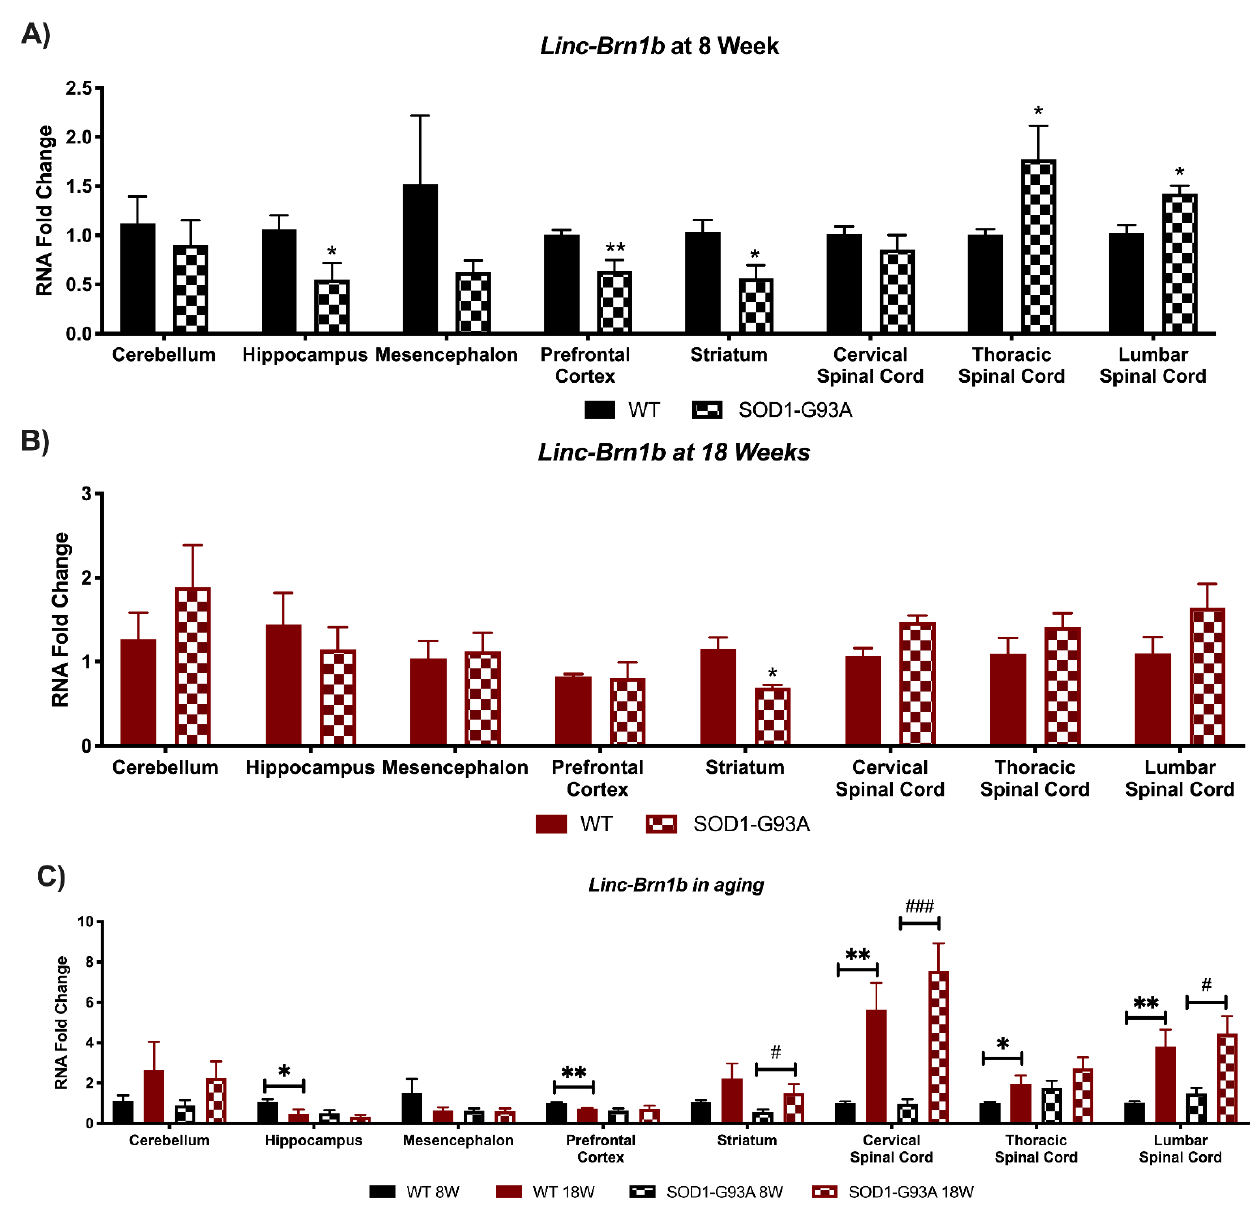
Figure 2. Global perturbations found in the expression of Linc-Brn1b in CNS areas of SOD1-G93A mice. RNA expression levels were evaluated by Real Time-PCR in the different conditions. Data are expressed as mean ± SEM. ( A ) Linc-Brn1b expression in 8 weeks old WT ( n = 6) mice versus 8 weeks old SOD1-G93A mice ( n = 6). * p < 0.05, ** p < 0.01 vs. WT. ( B ) Linc-Brn1b expression in 18 weeks old WT ( n = 6) mice versus 18 weeks old SOD1-G93A mice ( n = 6). * p < 0.05 vs. WT. ( C ) Linc-Brn1b expression in 8 weeks old WT mice versus 18 weeks old WT ( n = 6) and 8 weeks old SOD1-G93A mice versus 18 weeks old SOD1-G93A mice ( n = 6). * p < 0.05, ** p < 0.01 vs. WT 8W, # p < 0.05, ### p < 0.001 vs. SOD1-G93A 8W.